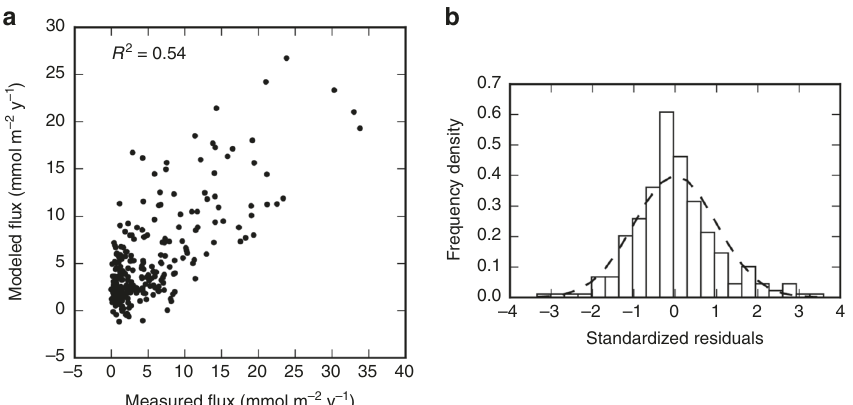
Fig. 3 Gradient boosted regression results. a Measured magnesium fl ux values vs. model results via leave-one-out cross-validation ( R 2 = 0.54 and p < 0.01), using the gradient boosting regression technique with the parameters listed in Table 6. b Histogram of standardized residuals of the cross-validation ( n = 269), with the dashed line showing an idealized normal distribution (mean = 0, standard deviation